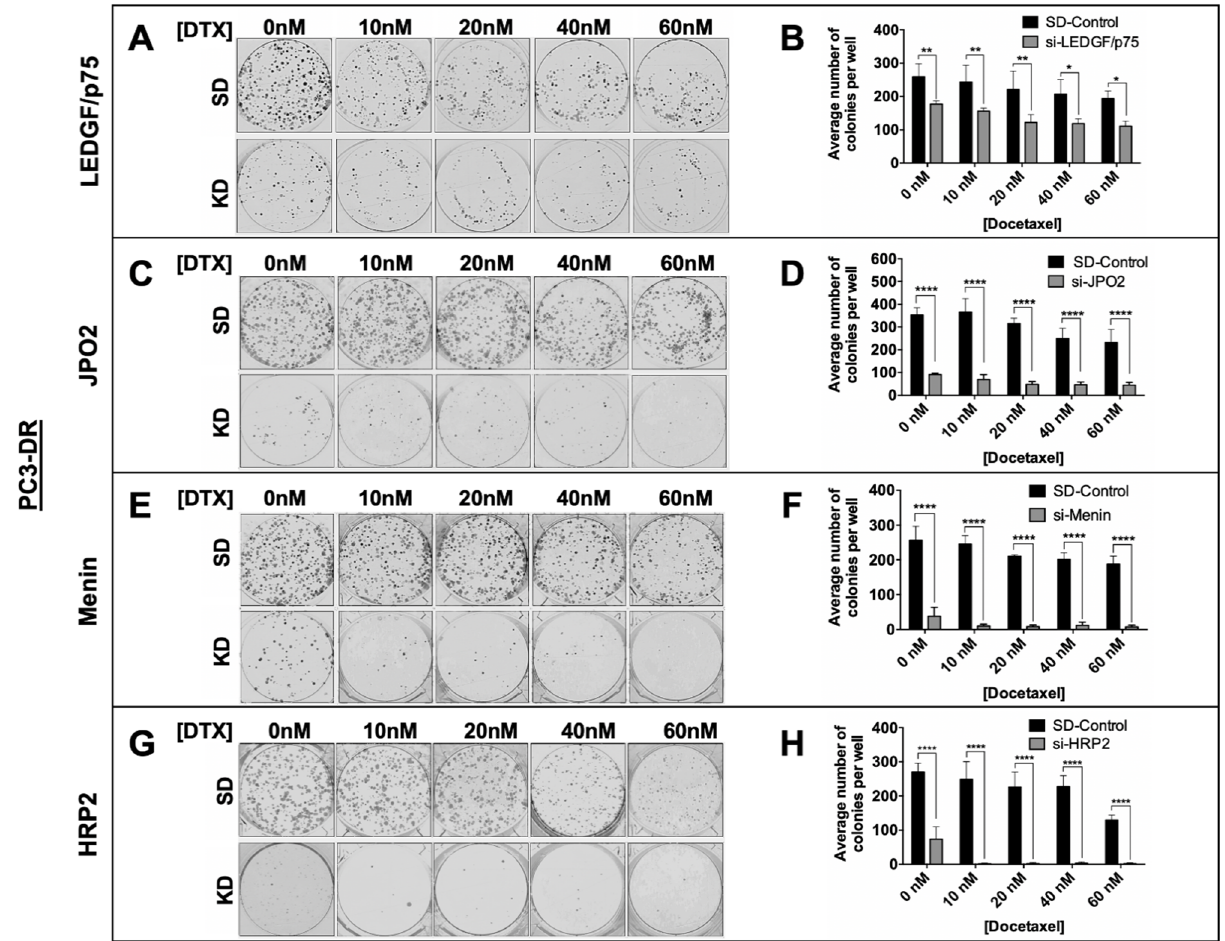
Figure 8. Knockdown of LEDGF/p75, JPO2, menin, or HRP2 inhibits the clonogenicity of PC3-DR cells. Representative images of clonogenic assay plates show decrease in colony formation in PC3-DR cells with LEDGF/p75 ( A ), JPO2 ( C ), menin ( E ), or HRP2 ( G ) knockdowns (KD) compared to scrambled duplex control cells (SD) in the presence and absence of DTX. Colonies were counted after 10 days of treatment. Adjacent bar graphs show quantification of PC3-DR colonies ( B , D , F , H ) and represent the average of colonies counted in at least three independent experiments. SEM was calculated. Statistical significance was determined by comparing the values for cells transfected with si-SD control oligos with values for cells with LEDGF/p75, JPO2, menin, or HRP2 knockdown in the presence or absence of DTX, using Student’s t -test (* p < 0.05, ** p < 0.01, **** p < 0.0001).